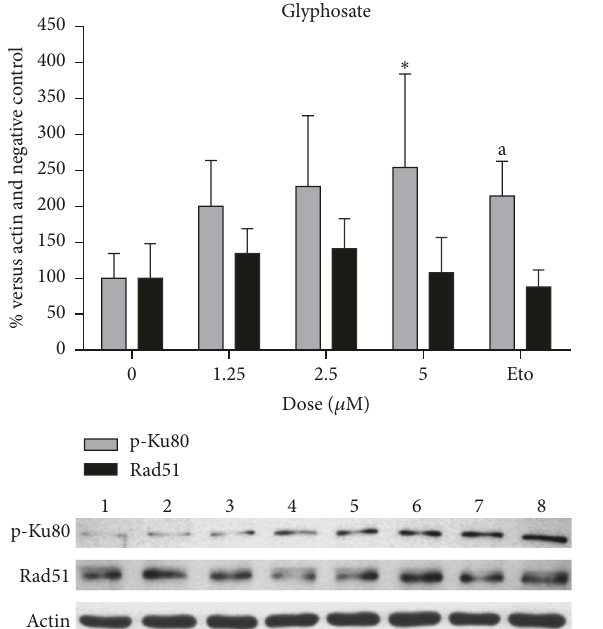
Figure 1: Graph: p-Ku80 protein increased due to treatments with glyphosate in a dose-dependent manner (linear regression, 𝑝 < 0.05 ). Individual concentrations were analyzed by Kruskal-Wallis and Dunn’s multiple comparison test; the asterisk shows that 5 microM was significantly different from the negative control. The bottom part shows a representative membrane: lane 1, negative control; lanes 2–4, pentachlorophenol (0.2, 1.0, and 5 microM);lanes 5–7,glyphosate(1.25,2.5,and5microM,seegraph);lane8,etoposide (10 microM).